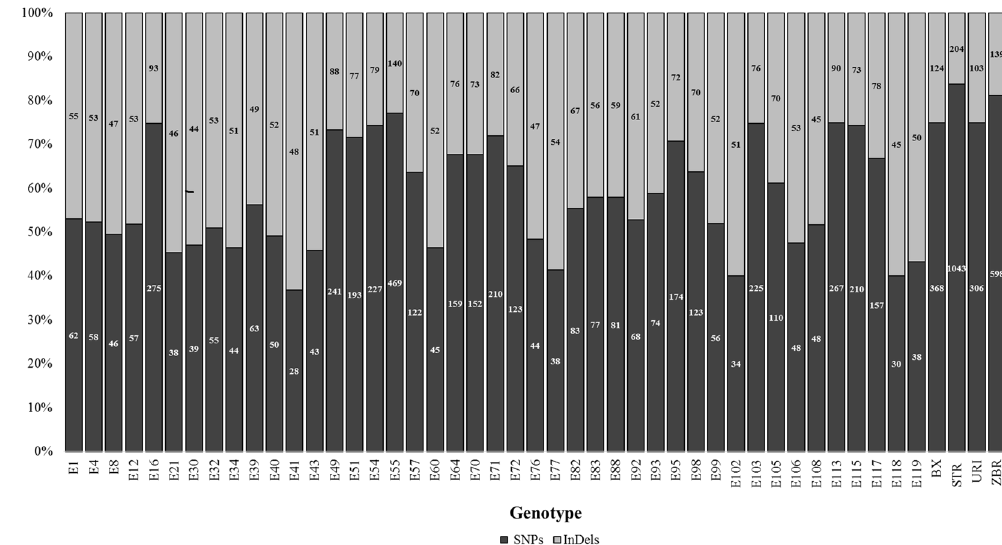
Figure 4. Stacked bar chart showing the number of SNPs and InDels called by GATK across all 47 tomato genotypes under